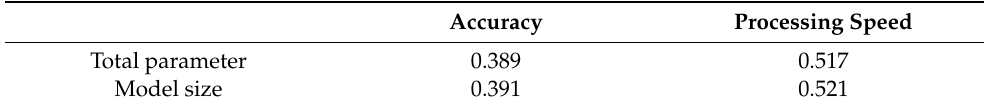
Table 4. Pearson correlation coefficient ( R ) matrix among model total parameter and size, accuracy, and processing